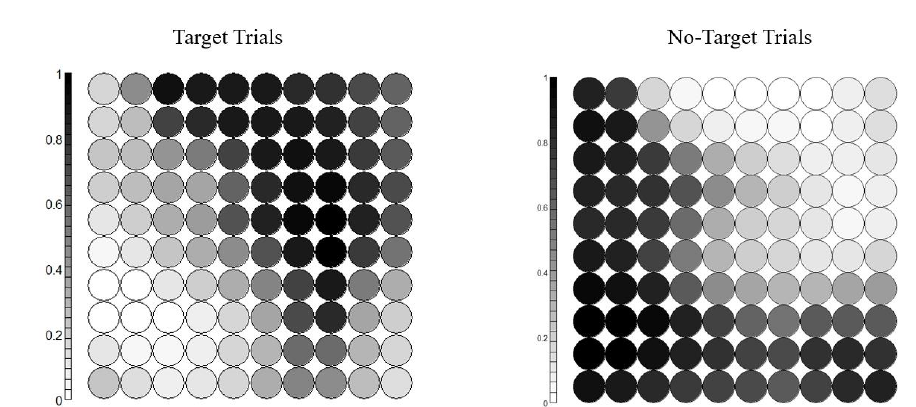
Figure 11. Cosine similarity between code vectors and two types of EEG